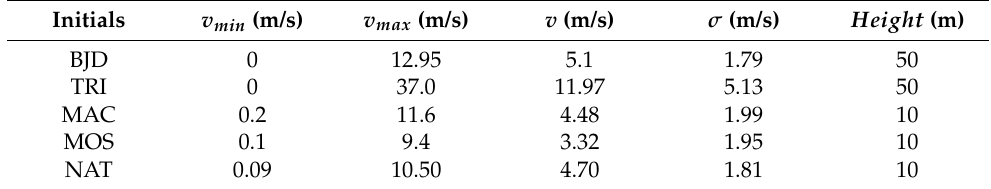
Table 2. Wind Speed Series